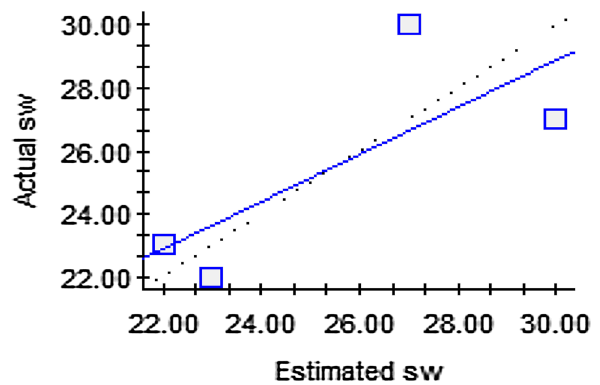
Fig. 8 Full logarithmic fractal diagram of concentration-area